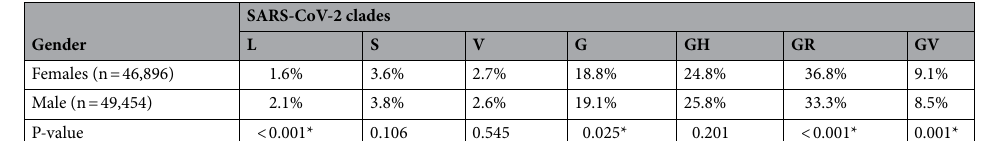
Table 4. Gender Distribution of SARS-CoV-2 clades. P-values were calculated using Chi-square test. *P-values < 0.05 are statistically significant.